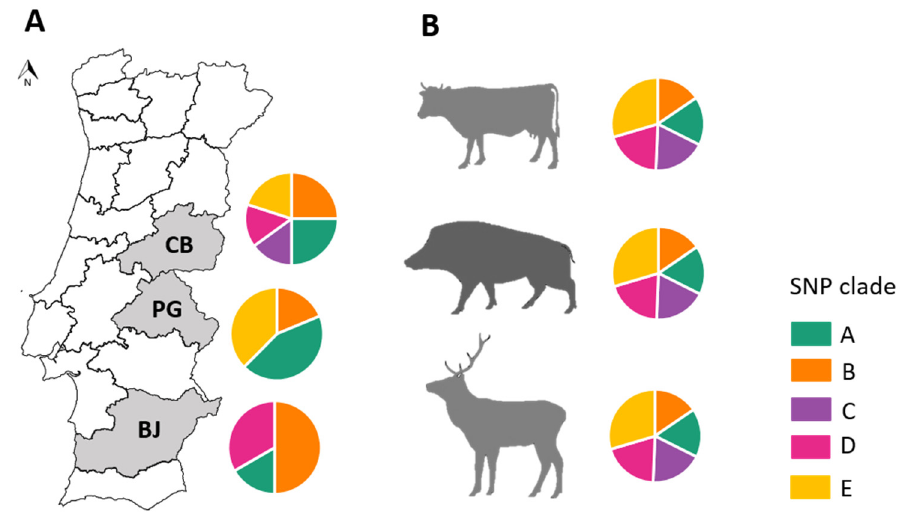
Figure 3. Distribution of SNP clades by: ( A ) geographic region (Beja (BJ), Castelo Branco (CB) and Portalegre (PG)) and ( B ) host species. Pie charts represent the proportion of each SNP clade by geographic region or host species. The colors of the pie charts identify the different SNP clades (A—dark cyan, B—orange, C—purple, D—pink and E—yellow).